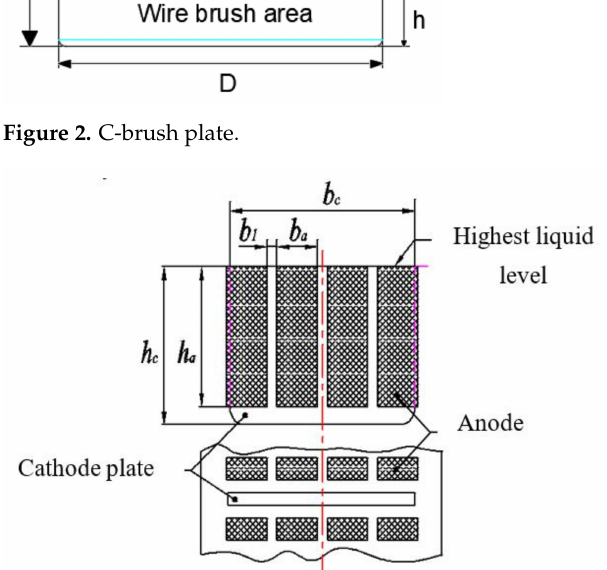
Figure 3. Structure and relative position of cathode and anode. When the bottom edge of the brush plate runs to the standard electrolyte liquid level depth of 0.2 m, the normal flux surface between the cathode and anode of the group is shown in the shaded part of Figure 4.